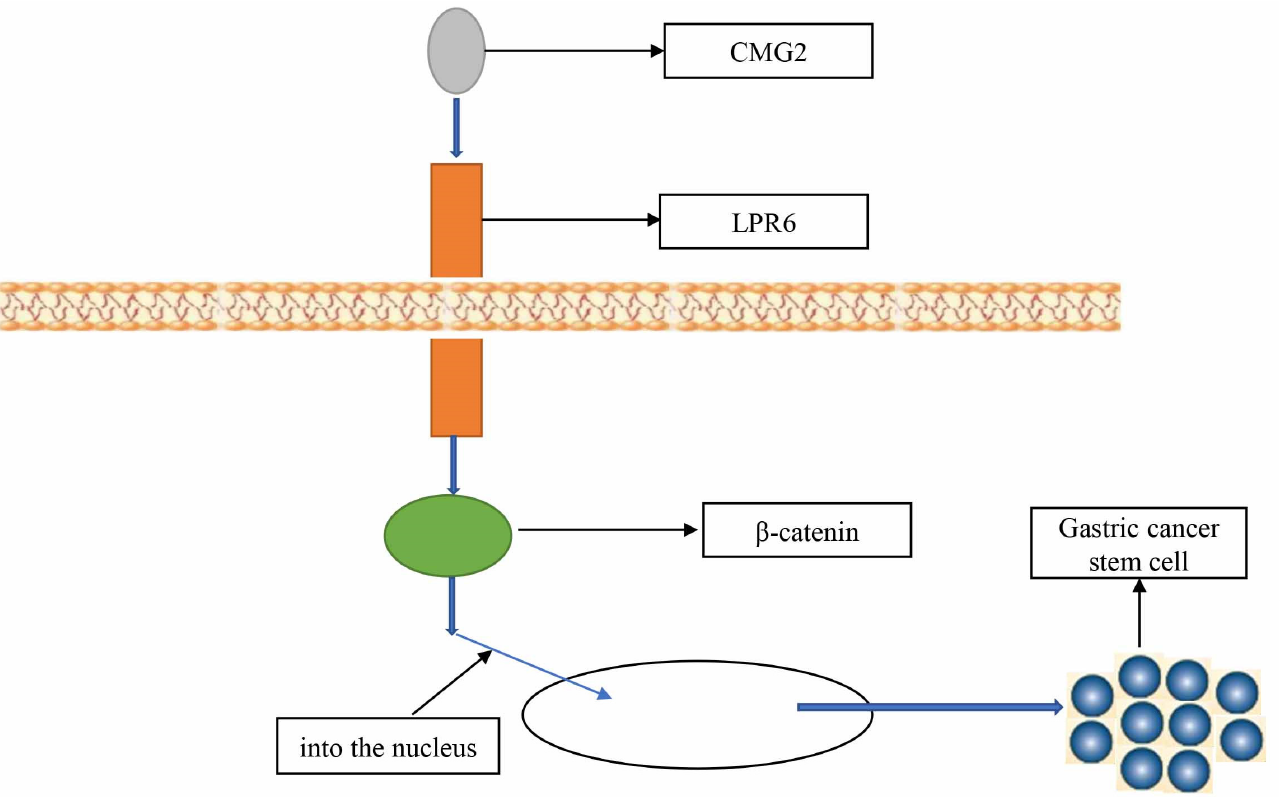
Figure 2. CMG2 maintains GC stem-like cell phenotype by activating a Wnt/ β -catenin pathway. 3.2. Genes Related to GCSCs-encoded Proteins with Unspecified Mechanisms or Not Acting